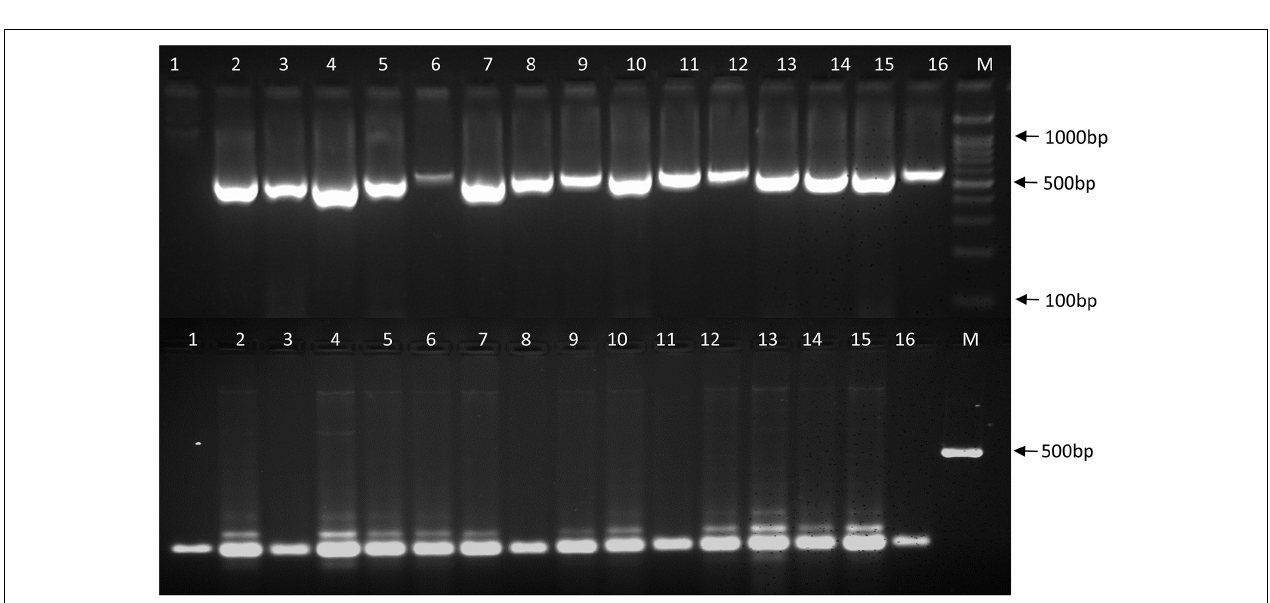
FIGURE 8 | Unweighted Pair Group Method with Arithmetic Mean-based dendrogram showing the clustering of different urdbean genotypes.